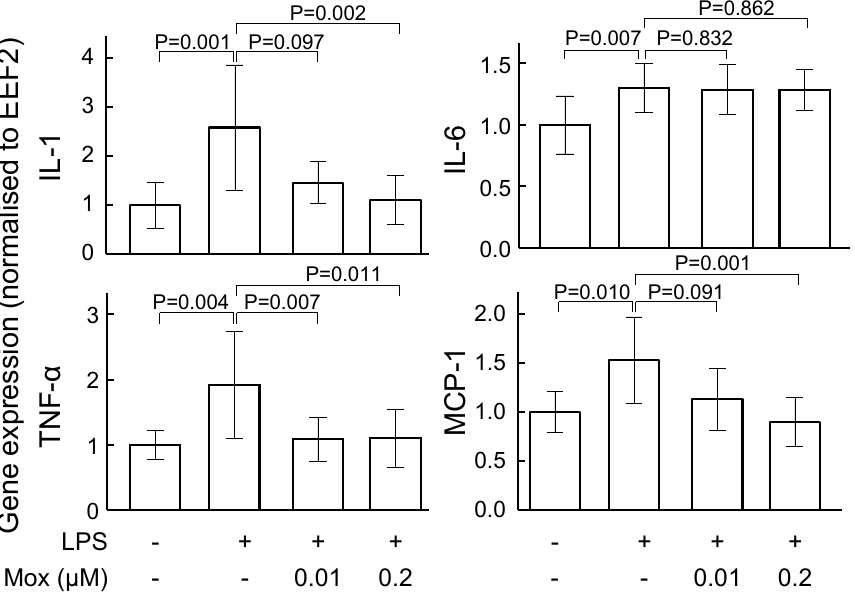
Figure 4. The effect of moxonidine on mRNA expression of inflammatory markers in VSMCs. Cells were incubated with lipopolysaccharide for 2 h in the absence or presence of moxonidine (0.01 or 0.2 µM). Then, mRNA was isolated and the expressions of IL1, IL-6, MCP-1 and TNF- α were quan- tified via quantitative PCR. The difference was analysed by Kruskal–Wallis one-way ANOVA fol- lowed by Bonferroni’s post hoc test. Data represent mean fold-change (vs. control) ± SD; N = 7–12. EEF2, eukaryotic elongation factor; IL, interleukin; LPS, lipopolysaccharide; MCP-1, monocyte chemoattractant protein-1; Mox, moxonidine; TNF- α , tumour necrosis factor- α ; VSMC, vascular smooth muscle cells. 2.3. Moxonidine Enhanced VSMC Migration Without Affecting VSMC Proliferation In Vitro Incubation with moxonidine (10 µM) stimulated the migration of VSMCs by 42% (Figure 5). However, incubation with moxonidine at concentrations of 0.015, 0.15, 1.5, 15 and 150 µM for 24 h did not affect cell proliferation as assessed by the MTS assay (Figure S3). Corroborating results were obtained when VSMC proliferation was assessed by the trypan blue method (Figure S4).